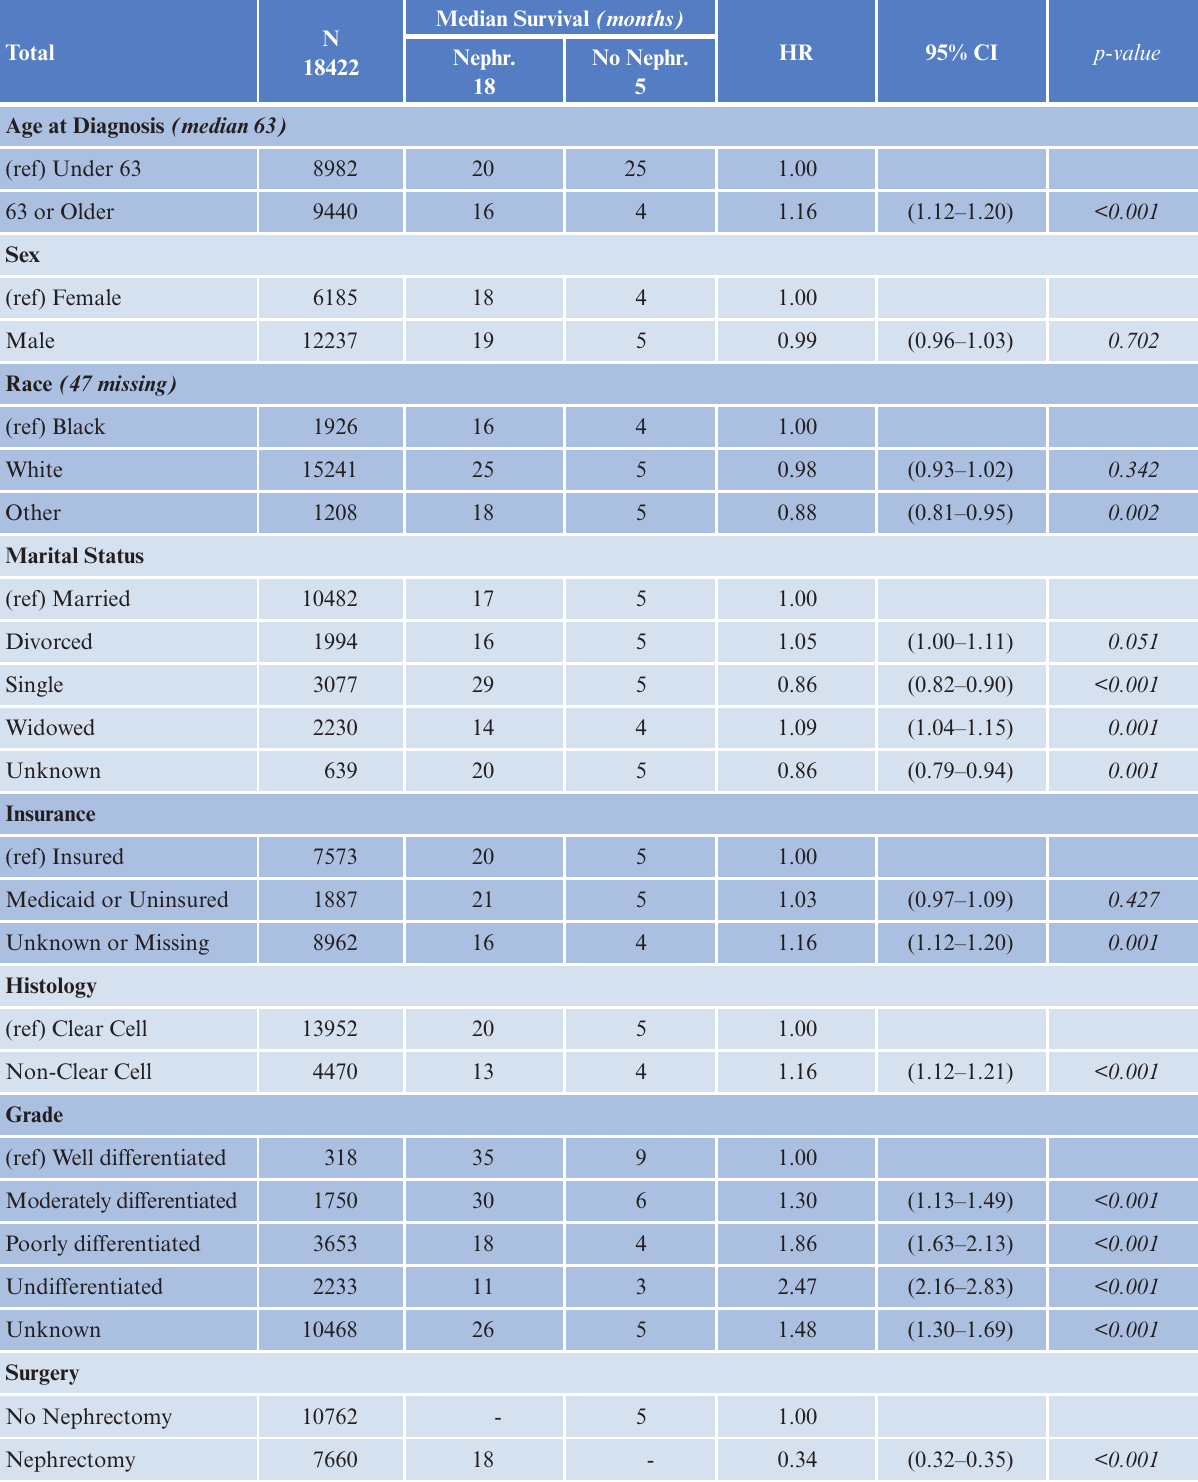
Table 3: All SEER Distant Stage Kidney Cancer (2000–2013) Survival Analysis (Median Survival, Adjusted Hazard Ratio, 95% Confidence Interval, and